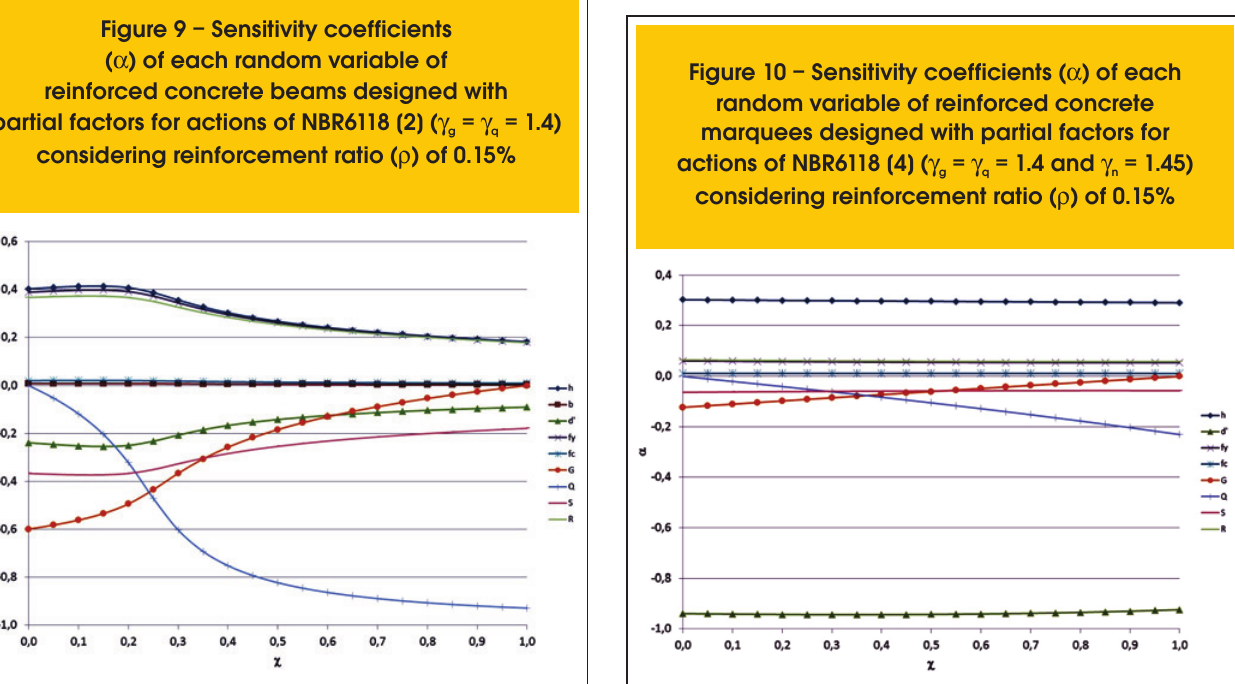
Figure 9 – Sensitivity coefficients ( a ) of each random variable of